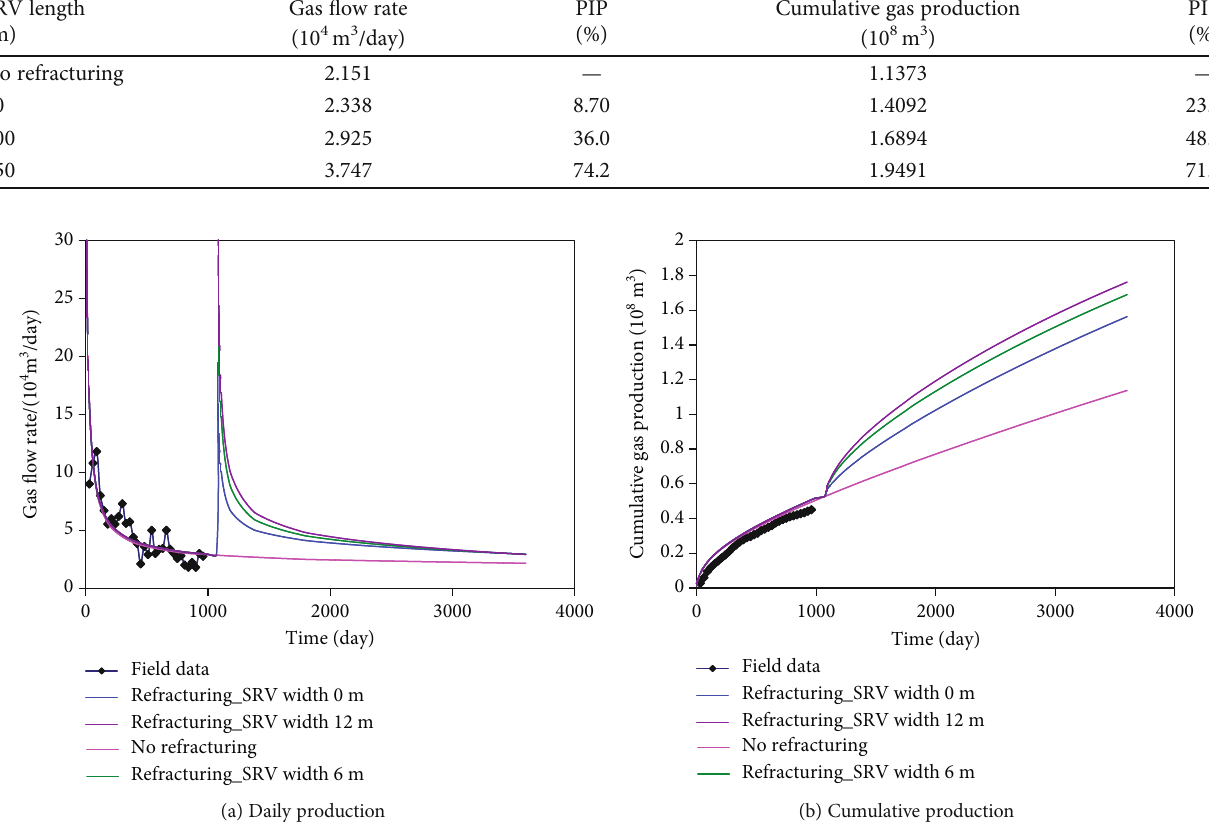
Figure 18: E ff ect of SRV width of refractured new fracture on daily and cumulative gas